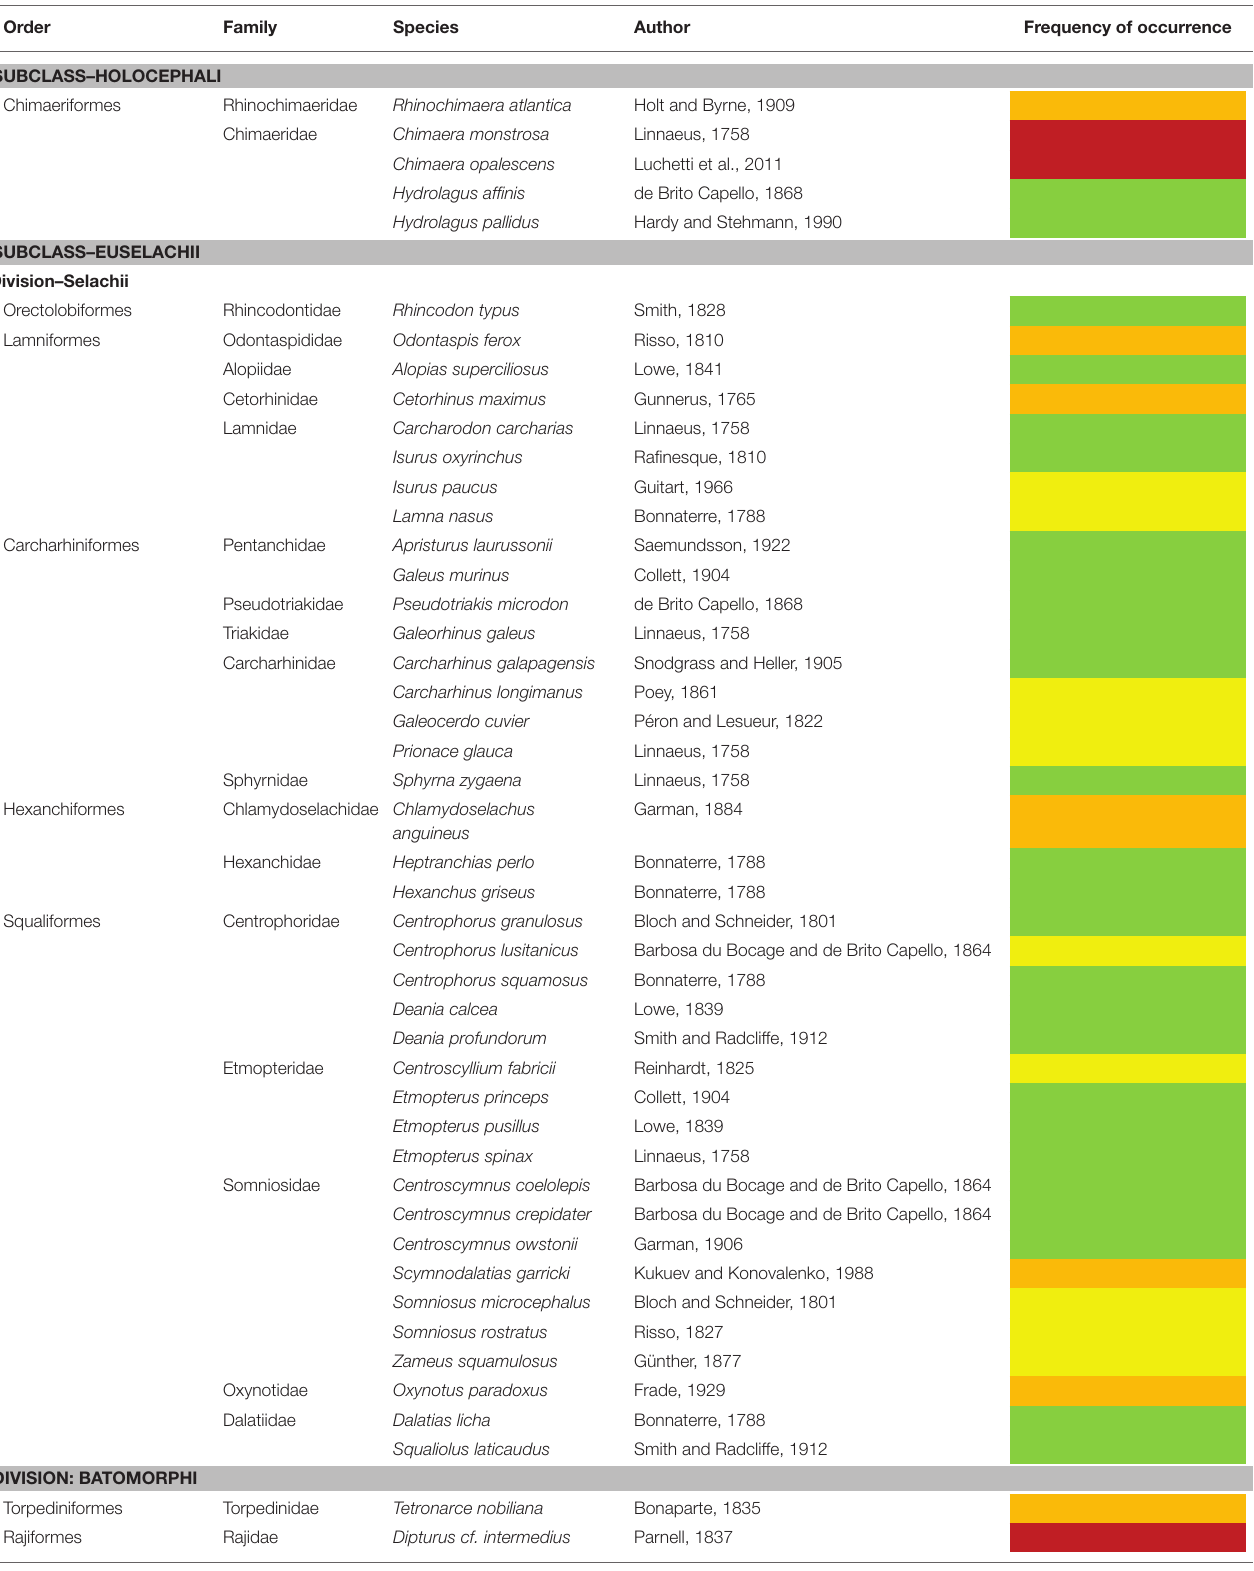
TABLE 1 | Final species checklist with color codes; green: common, yellow: rare, orange: rare due to gear constraints, red: uncertain identification.